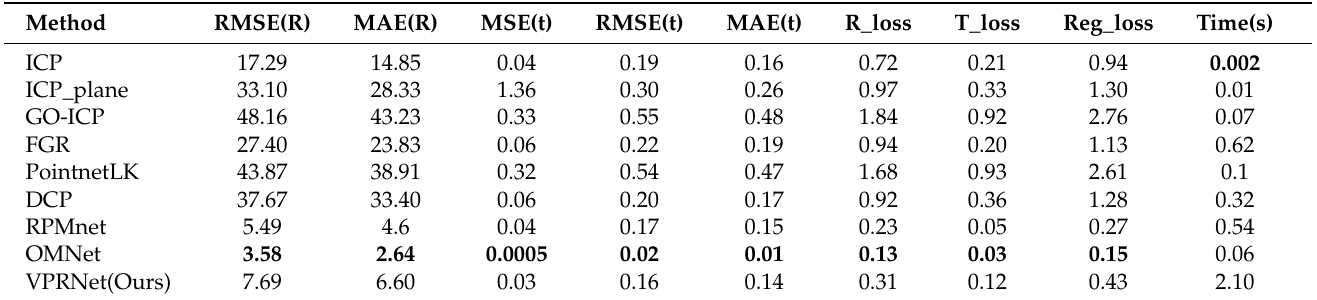
Table 3. Results on noisy point clouds in ModelNet40. Bold numbers are the smallest in the current column, and represent the best performance. Lower is better. Our algorithm is in the front rank among all